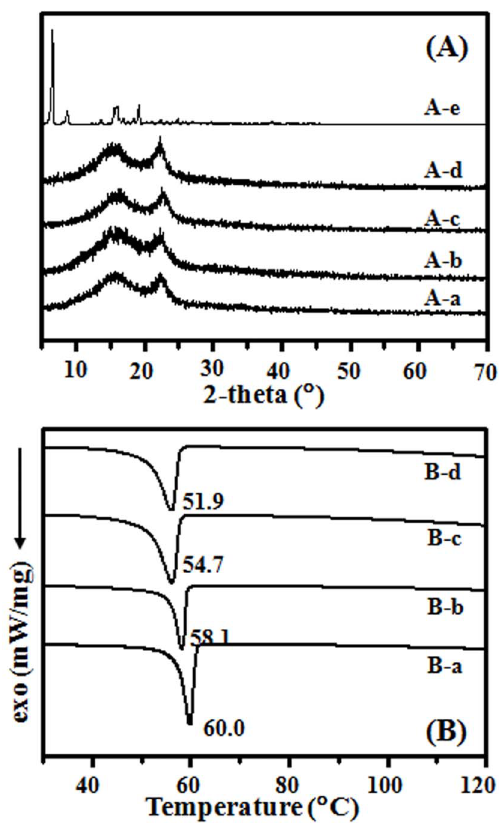
Figure 3. X-ray diffraction profiles (A) and DSC analysis (B) of electrospun fibers. PLLA fibers (A-a and B-a), PLLA-2% (A-b and B-b), PLLA-6% (A-c and B-c), PLLA-10% (A-d and B-d) and Ginsenoside Rg3 (A- e).